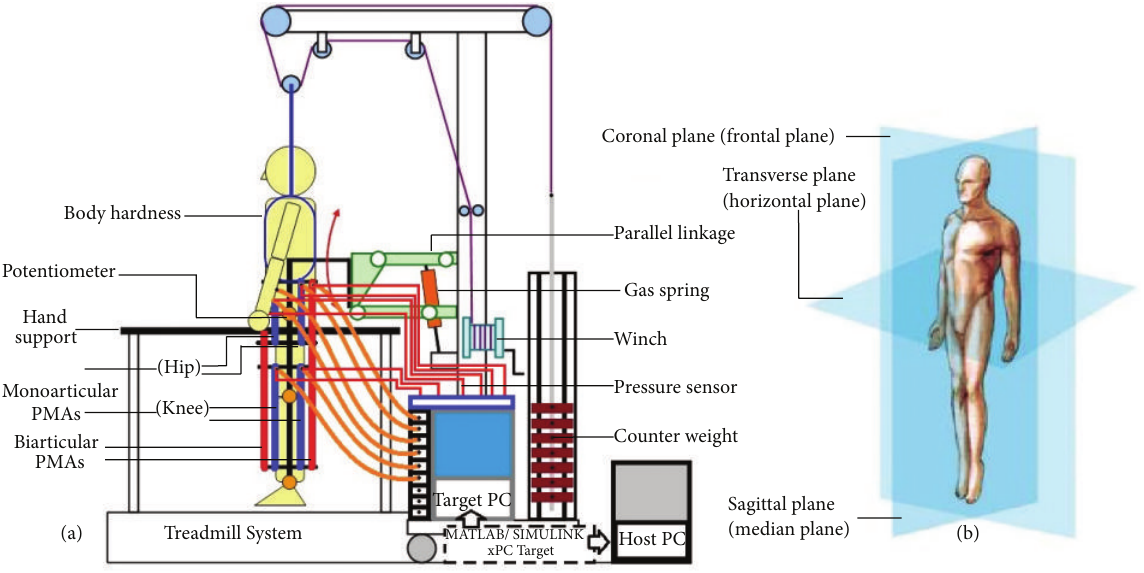
Figure 1: Schematic diagram for body weight support gait training system (AIRGAIT).